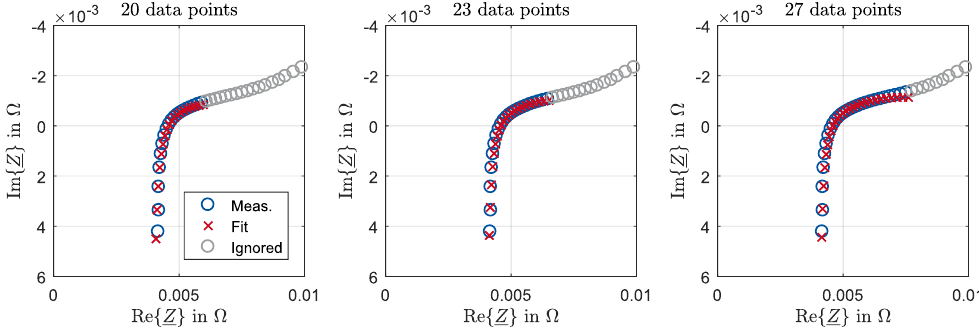
Figure A2. The impedance spectrum of TC 1 in hard AK3.4 recorded after the cycling phase (90FCE) was fitted three times, always with a different number of data points.